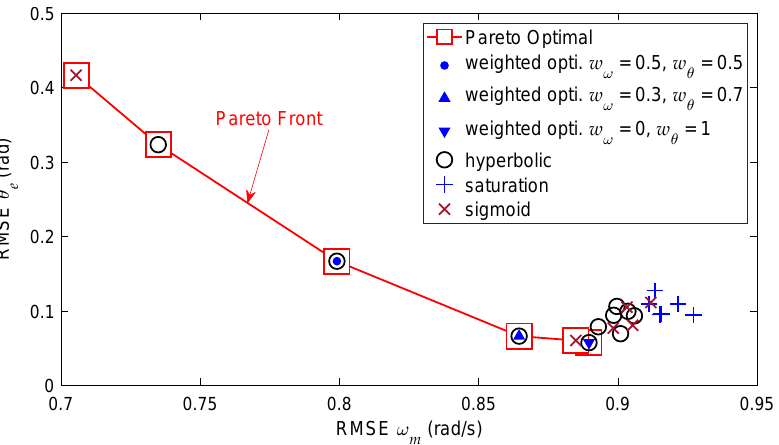
Figure 7. The overview of optimization results in the RMSE ω m and RMSE θ e space.